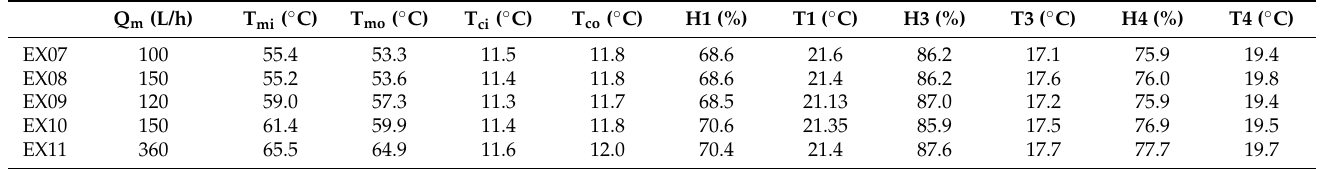
Table 4. Measured temperatures and humidity for combination of MM004 and MM007 and two condensers. Q m (L/h)